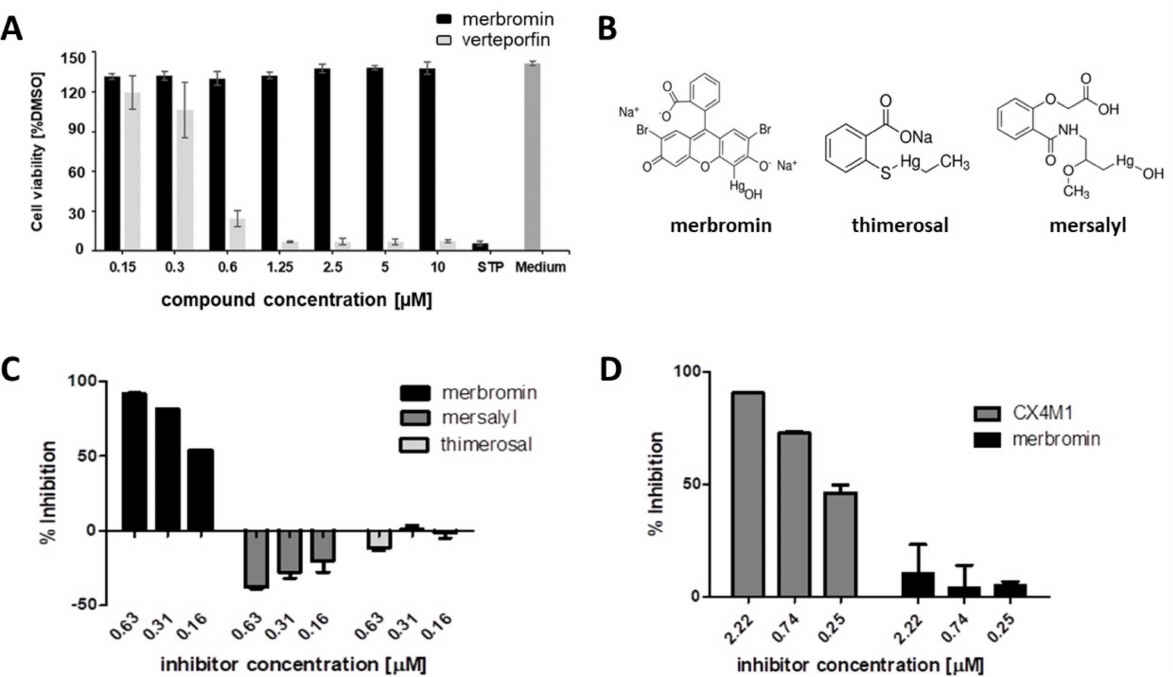
Figure 3. Cytotoxicity and selectivity of merbromin. ( A ) Cytotoxicity of merbromin and verteporfin. ( B ) Chemical structures of merbromin, thimerosal, and mersalyl. ( C ) Effect of merbromin, thimerosal, and mersalyl o the HCMV pUL50-pUL53 interaction. ( D ) Effect of the CXCR4 mimetic peptide CX4M1 and merbromin on the HIV-1 gp120–mAb 447 52D interaction. Error bars present SDs ( A ) and SEMs ( B – D ), respectively, of at least two experiments. See Section 2.3 ( A ), Section 2.1 ( B ) and Section 2.2 ( D ) for experimental